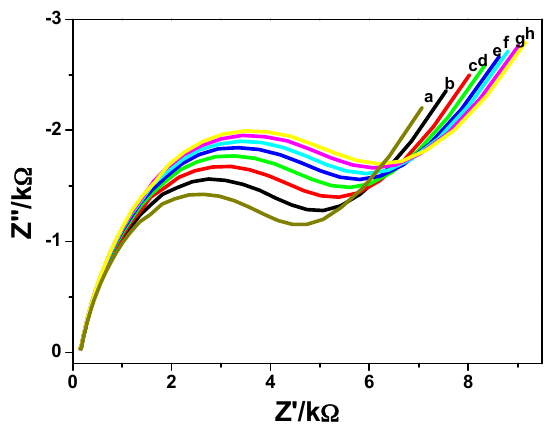
Figure 10. EIS responses in PBS, of the FB 1 immunosensor (GCE/PDMA-MWCNT/anti-Fms) at the following concentrations of FB 1 : ( a ) 0 ng·L − 1 ; ( b ) 7 ng·L − 1 ; ( c ) 14 ng·L − 1 ; ( d ) 21 ng·L − 1 ; ( e ) 28 ng·L − 1 ;